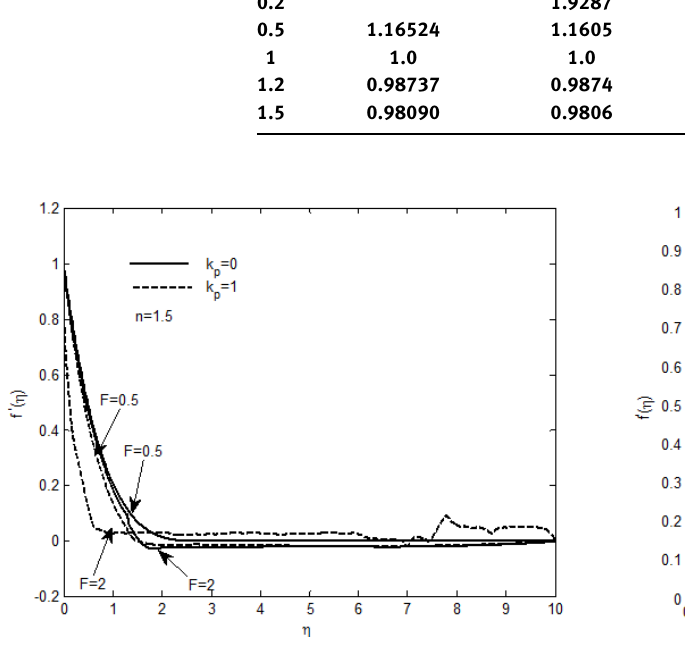
Figure 3: Horizontal velocity profiles